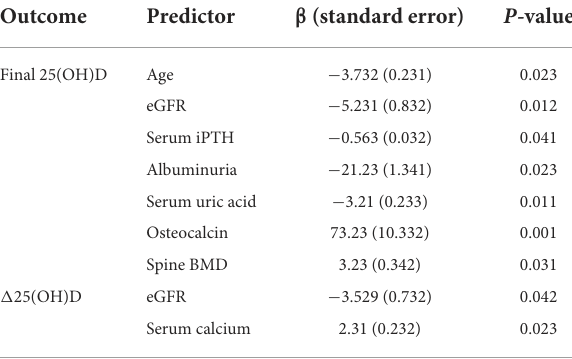
TABLE 4 Predictors of final 25(OH)D levels and changes in serum concentrations of 25(OH)D during vitamin D supplementation; results of multiple linear regression